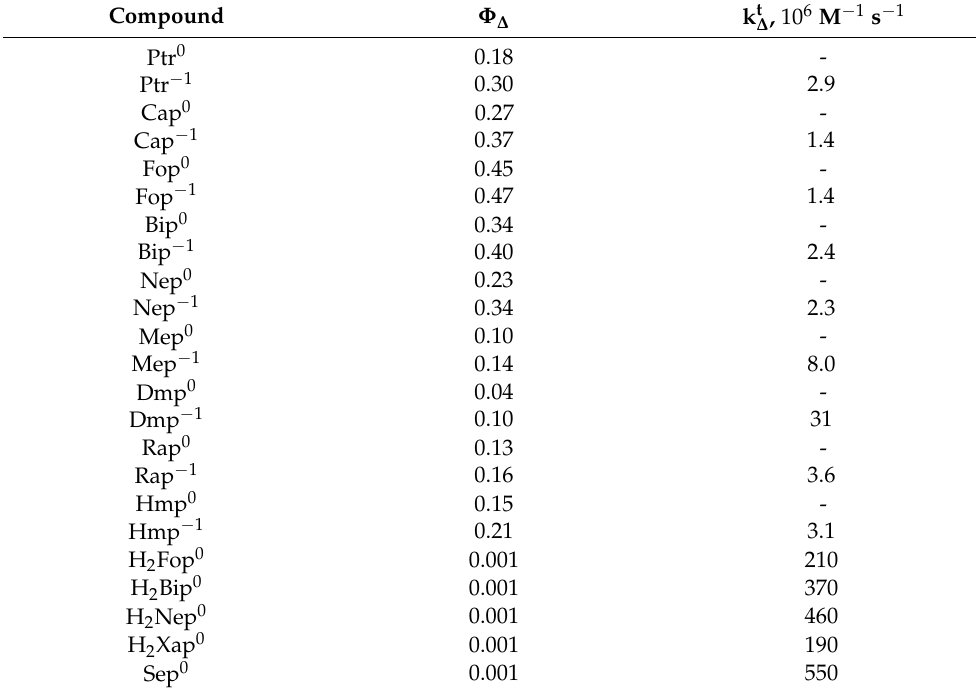
Table 2. Quantum yields of 1 O 2 generation and rate constants of 1 O 2 total quenching